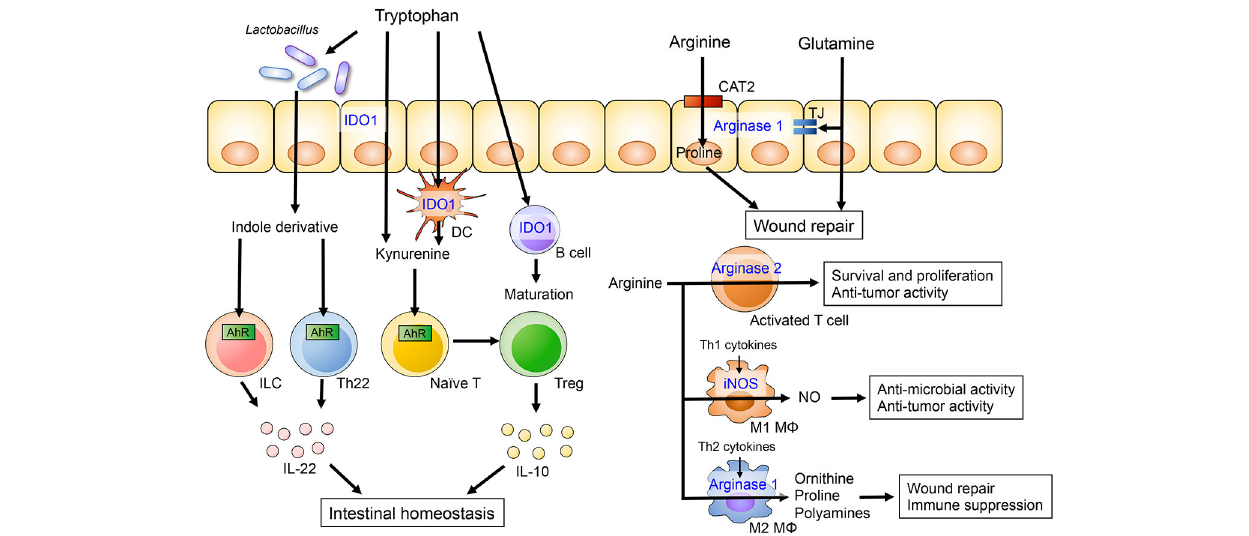
FIGURE 1 | The role of dietary amino acids in intestinal homeostasis. Dietary tryptophan is metabolized to kynurenine or indole derivatives by host cells or the gut microbiota, respectively. Kynurenine promotes the differentiation of Treg and induces IL-10 production by Treg cells through AhR. Lactobacillus species are capable of catabolizing tryptophan into indole derivatives that are ligands for the AhR. Activation of AhR in gut-resident T cells and ILC enhances production of IL-22, which in turn potentiates mucosal barrier integrity. Arginine and glutamine metabolism in intestinal epithelial cells is associated with epithelial barrier and intestinal wound repair. Arginine also plays an important role of the immune system. Arginine is catabolized by iNOS in M1 macrophages and by arginase II in M2 macrophages. The arginine metabolisms regulate anti-microbial and -tumor activity and immune suppression in M1 and M2 macrophages,